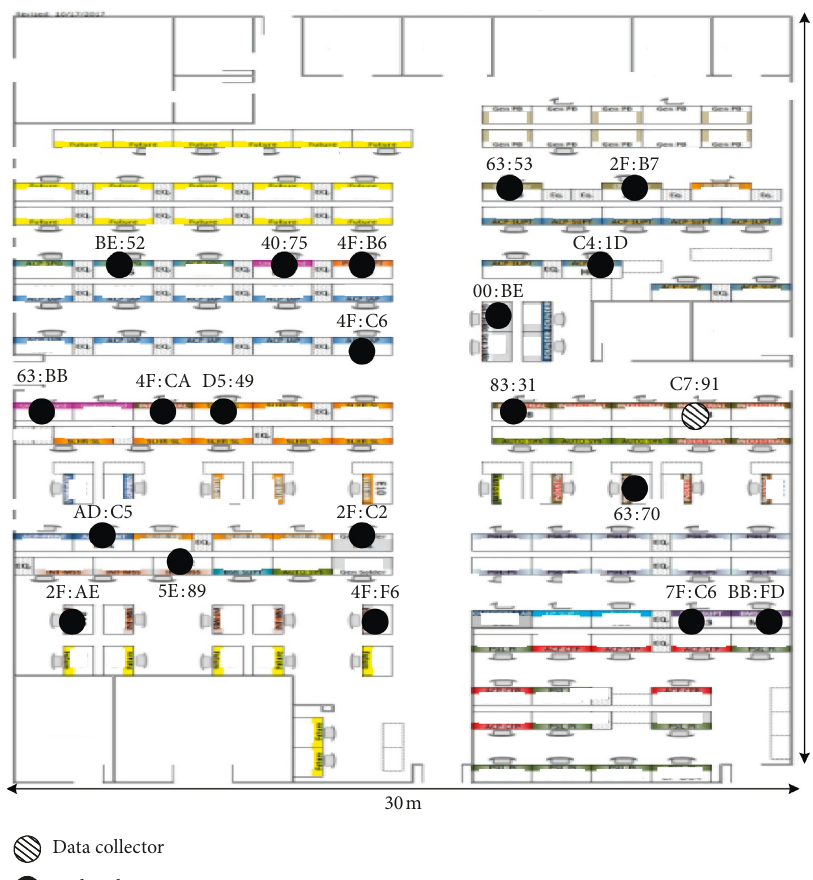
Figure 16: 20-node network